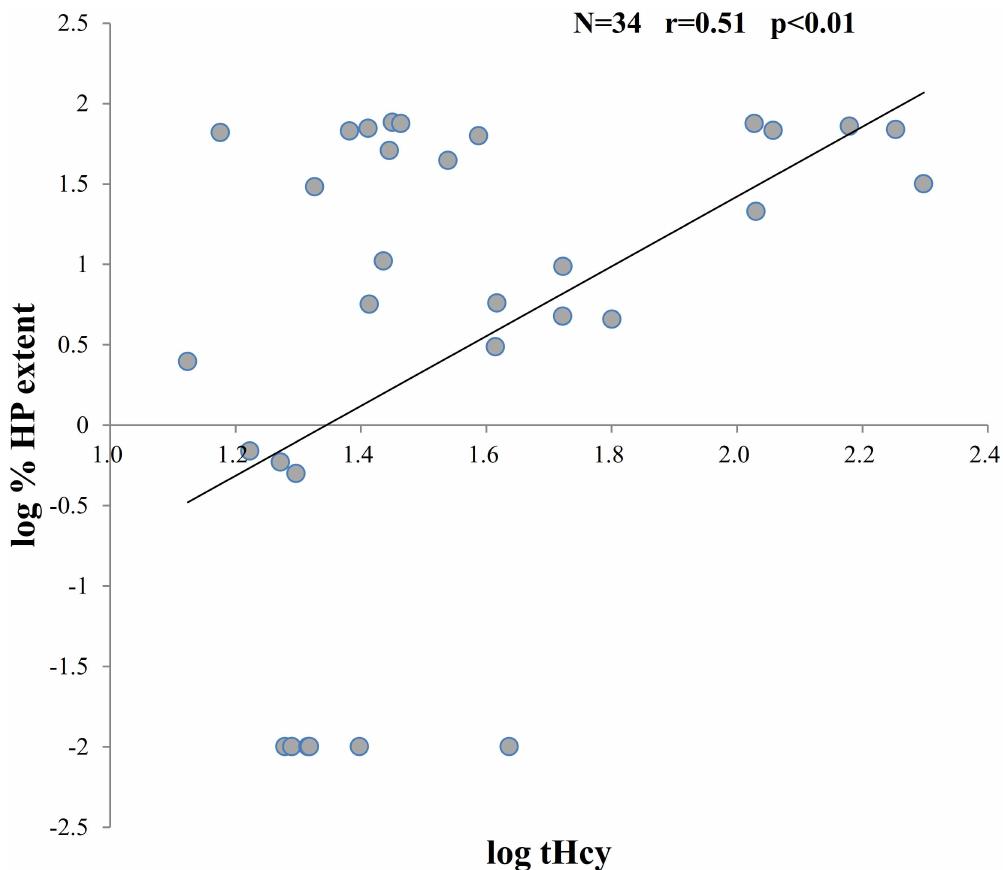
Fig 4. Correlation between log %HP extent and log tHcy. Log %HP extent was strongly associatedwith log tHcy level linearly.